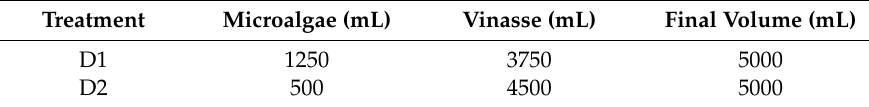
Table 2. Inoculation of diluted C. vulgaris in vinasse.